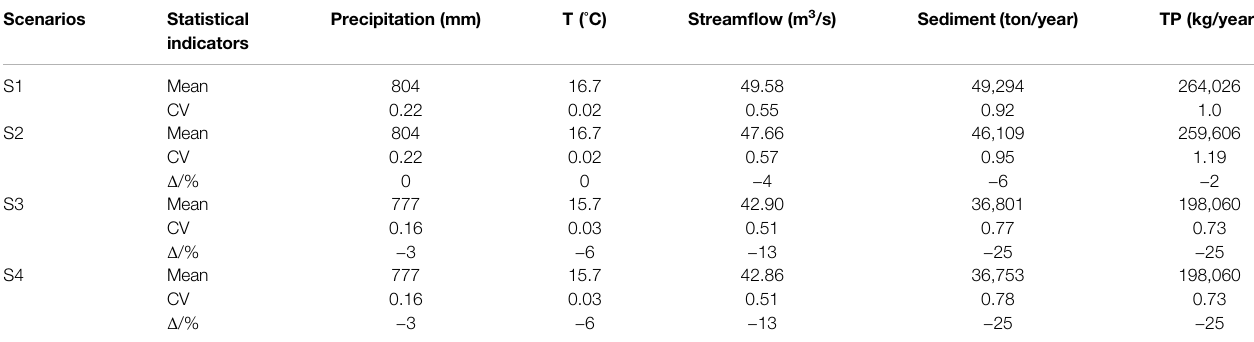
TABLE 5| Theimpactofclimatechange/land-usechangeonmulti-annualaverageand Coef fi cientofVariation(CV)ofprecipitation,temperature,stream fl ow,sediment,and TP loads compared to the baseline period (2000 –